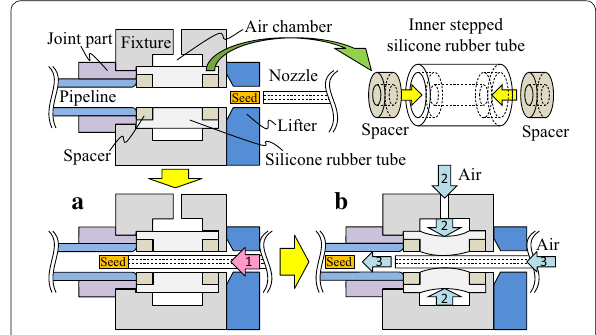
Fig. 15 Tube tightening mechanism. a – b Show the motion proce-